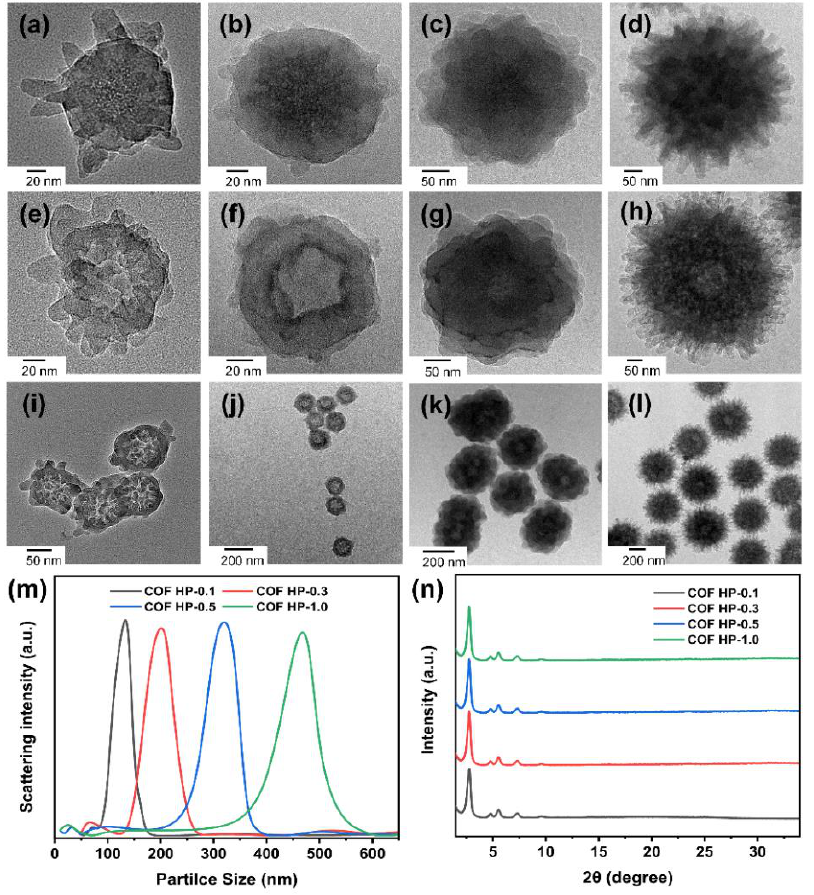
Figure 4. The TEM images of a series of DMSN@COF ( a – d ) and COF HP ( e – l ) synthesized with different COF and DMSN feed ratios: COF HP-0.1( a , e , i ), COF HP-0.3 ( b , f , j ), COF HP-0.5 ( c , g , k ), and COF HP-1.0 ( d , h , l ). Particle size distributions ( m ) and the XRD patterns ( n ) of COF HP-0.1, COF HP-0.3, COF HP-0.5, and COF HP-1.0.